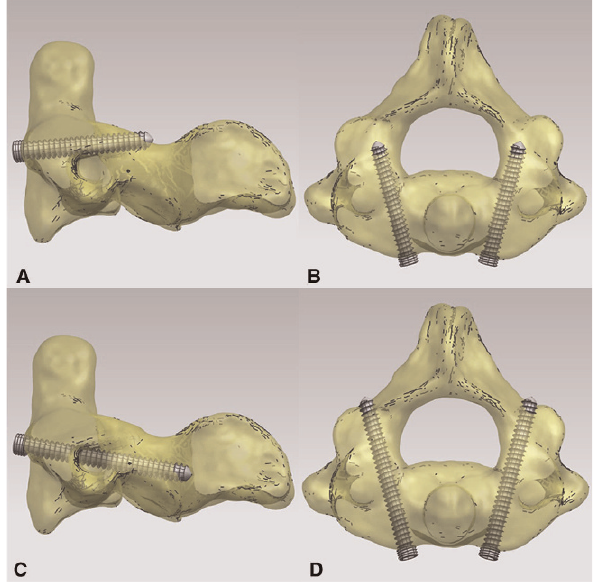
Figure 1 - A diagram showing the definitions of C2TOAMS and C2TOTPS. A The lateral view of C2TOAMS; B The axial view of C2TOAMS; C The lateral view of C2TOTPS; D The axial view of C2TOTPS.